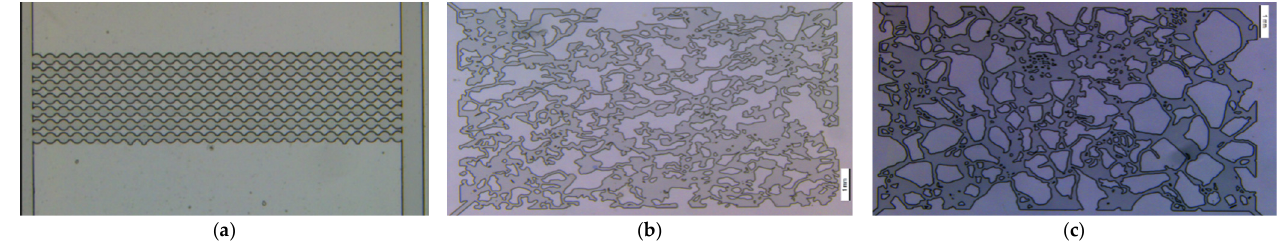
Figure 3. Different types of microfluidic chip models. ( a ) Idealized pore structure mesh model, 10 μ m; ( b ) Complex tortuous structure model, 50 μ m; ( c ) Complex tortuous structure model, 200 μ m.